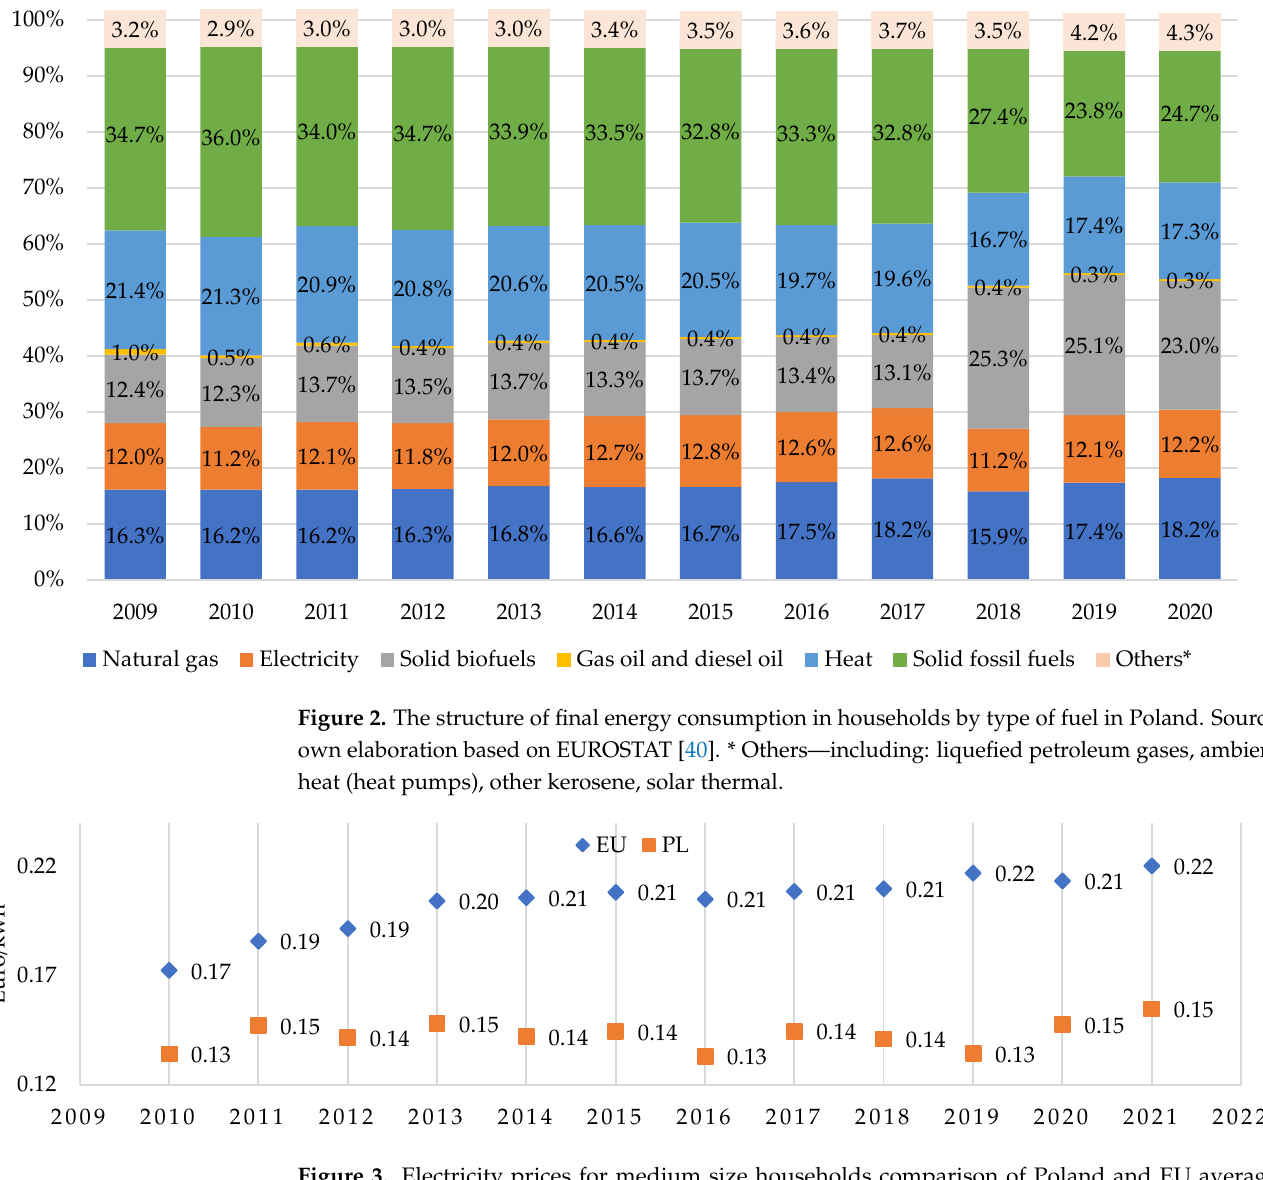
Figure 3. Electricity prices for medium size households comparison of Poland and EU average. Source: own elaboration based on EUROSTAT [42].